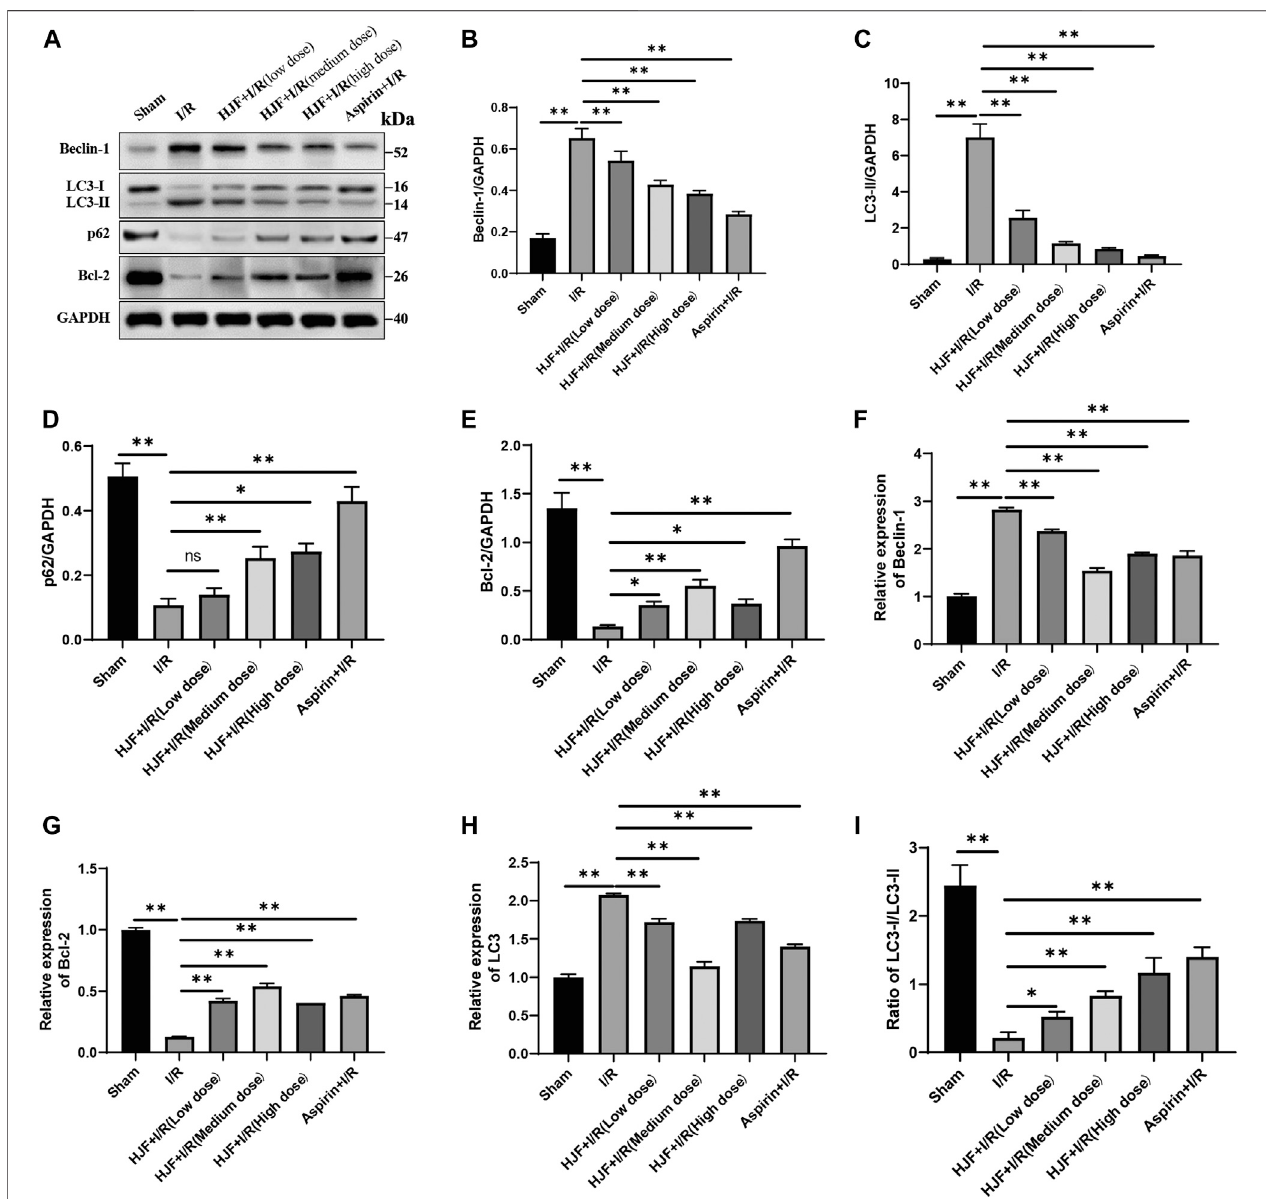
FIGURE 2 | Effects of HJF on autophagy-related proteins in rats subjected to I/R. (A) , Representative western blot images of autophagy-related proteins; (B) , Quanti fi cationofthelevelsofBeclin-1; (C) ,Quanti fi cationofthelevelsofLC3-II; (D) ,Quanti fi cationofthelevelsofp62; (E) ,Quanti fi cationofthelevelsofBcl-2; (F) ,mRNA expression ofBeclin-1; (G) , mRNA expression of Bcl-2; (H) , mRNA expression of LC3; (I) , Ratio of LC3-I/LC3-II. The data are shown as the means ± SDs in each group (n (cid:1) 3). * p < 0.05, ** p < 0.01. I/R, ischaemia/reperfusion; HJF, Huoxue Jiedu Formula.